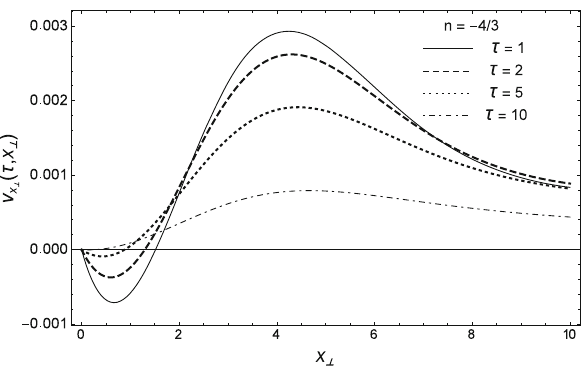
Fig. 11 (cid:5) 1 (τ, x ⊥ ) as a function of x ⊥ for different values of α at τ 0 = 1 fm